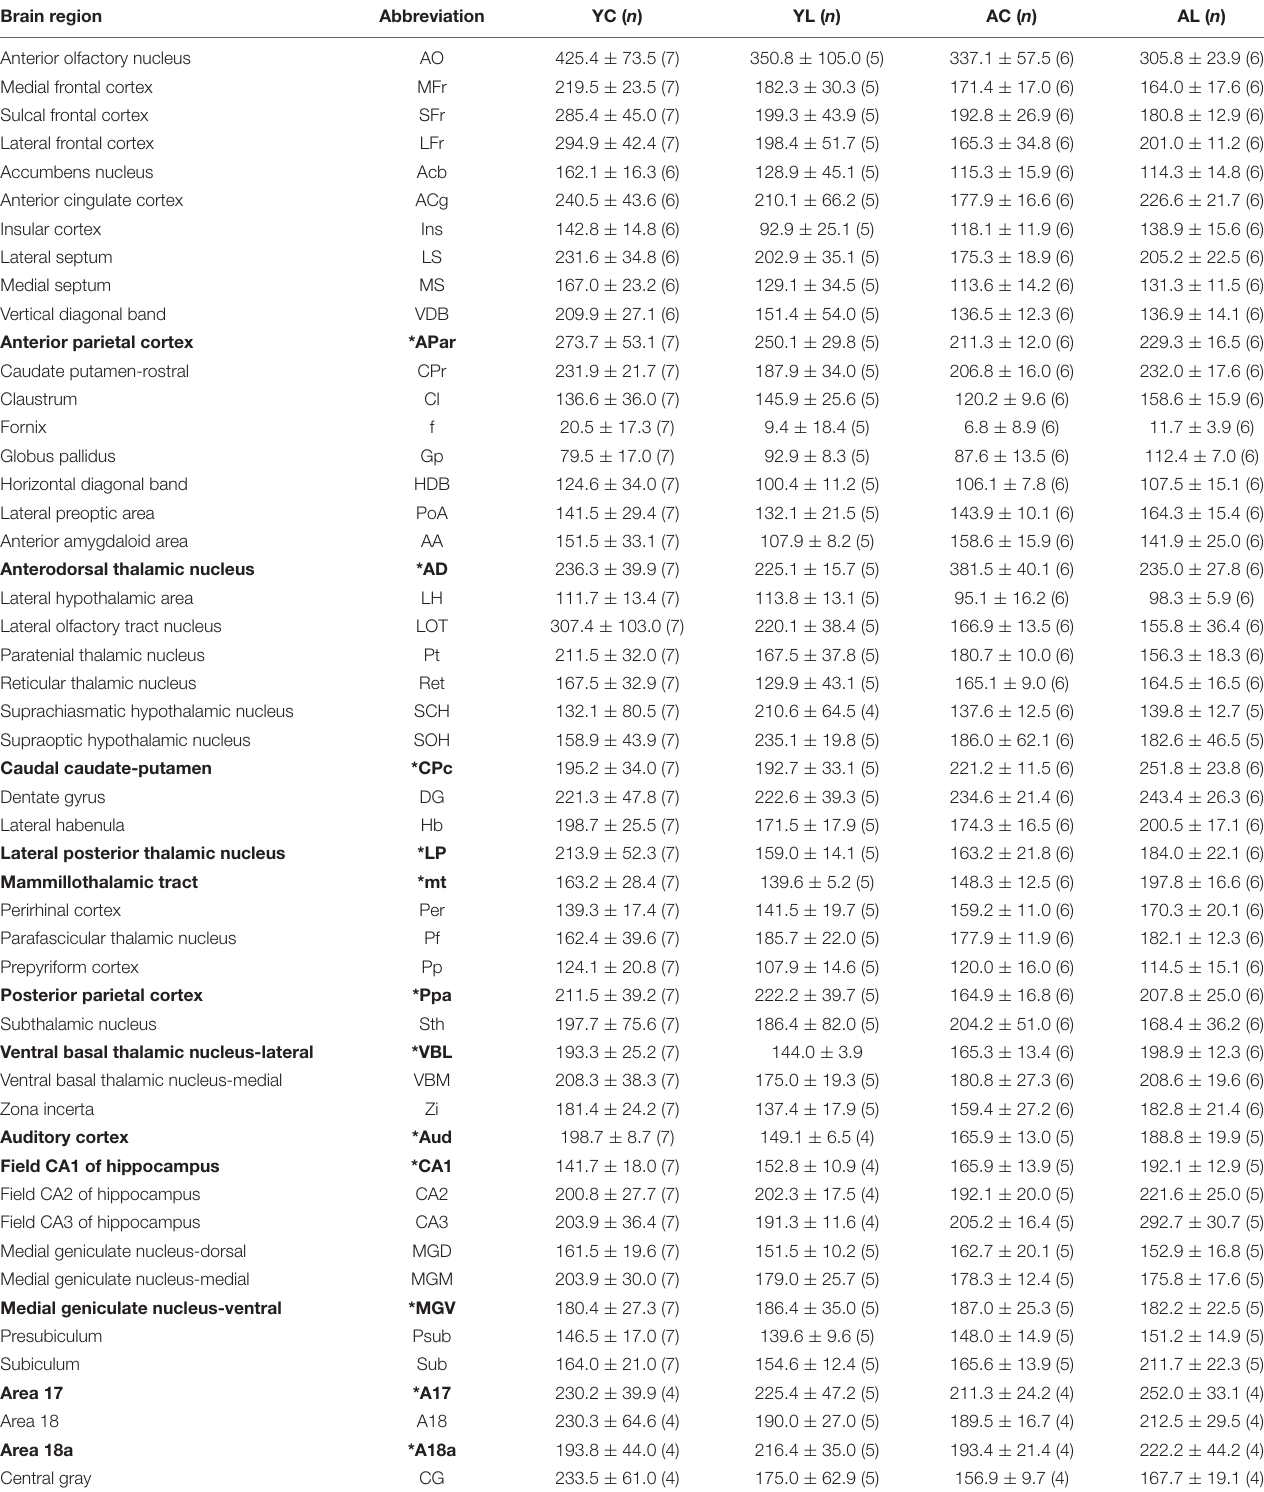
TABLE 1 | Means and standard errors of cytochrome c oxidase activity ( µ mol of cytochrome c oxidized/min/g of wet tissue weight) of all regions of interest from YC, YL, AC, and AL groups. Brain